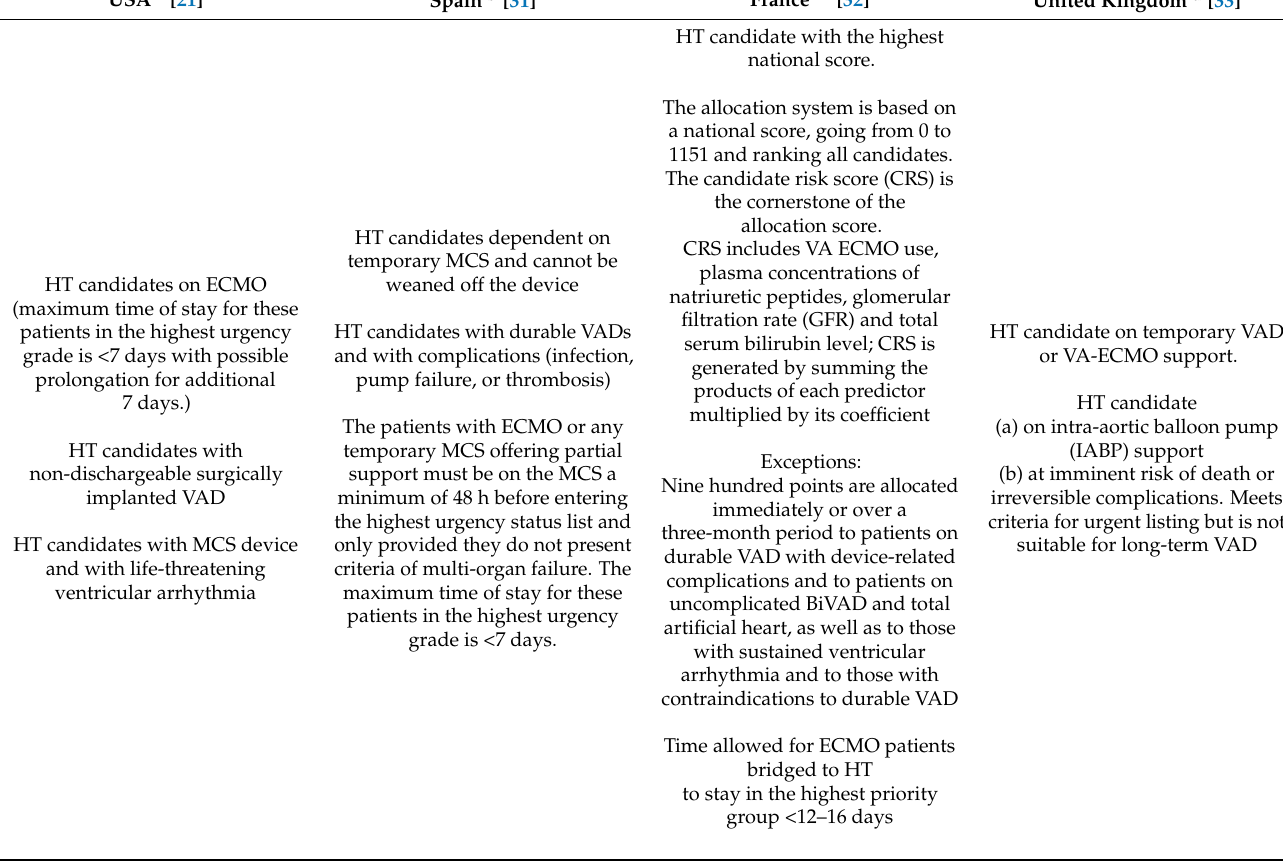
Table 3. The comparison of highest priority groups between the contemporary allocation systems in the USA, Spain, France and the United